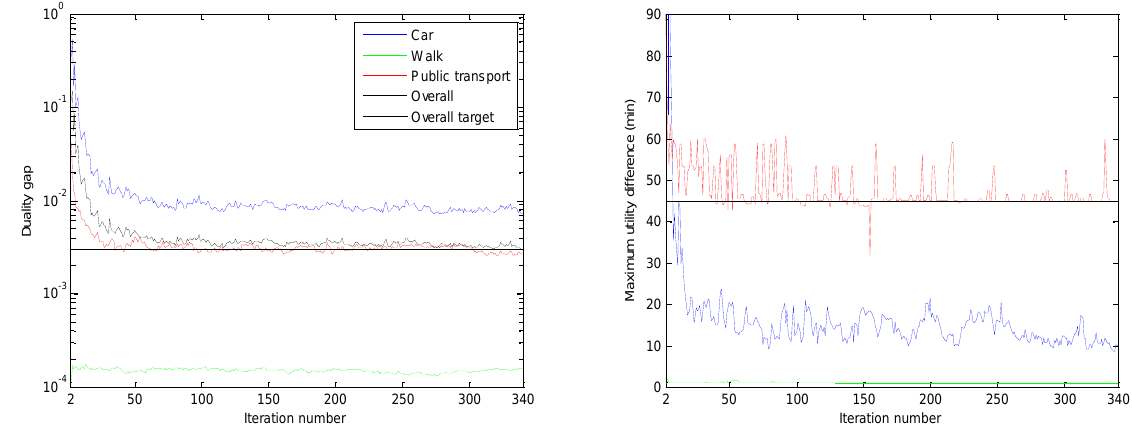
Figure 6. Convergence of (a) the duality gap (b) the maximum utility difference Proceeding with the simulation of the emergency conditions, the average status of the transportation system between 17:30 and 18:00 is visualized in Figure 7 for vehicular traffic and in Figure 8 for the public transport network (the pedestrian traffic is omitted here for brevity). For the vehicular traffic (Figure 7), we notice many traffic jams on roads inside Delft. Because of the combination of inbound, outbound and background traffic with various destinations each, we observe no clear pattern regarding the directions of traffic jams on the urban roads – at various places, both directions of the same road are heavily congested simultaneously. Looking at access points to the motorways, the traffic conditions are especially bad for the people that try to evacuate to the